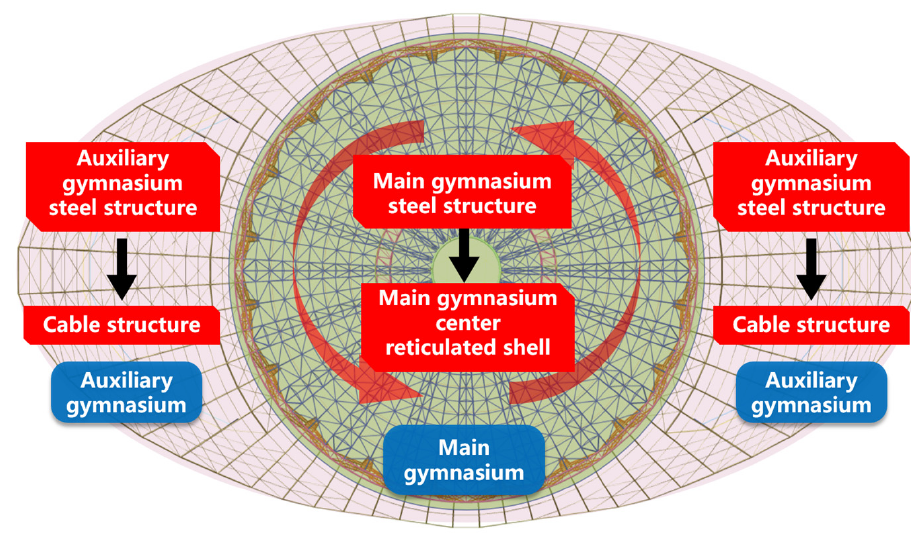
Figure 3. Illustration of the steel structure construction sequence.